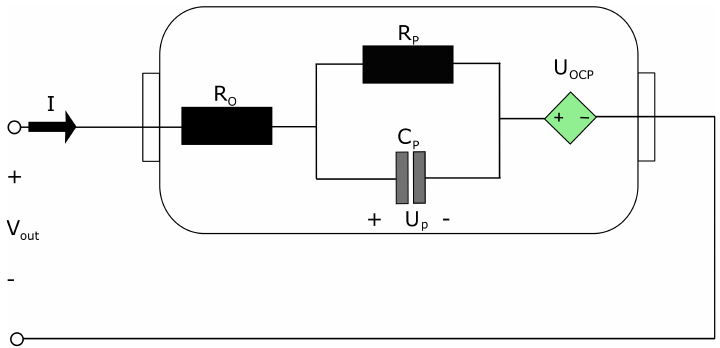
Figure 2. First Order RC Equivalent Circuit